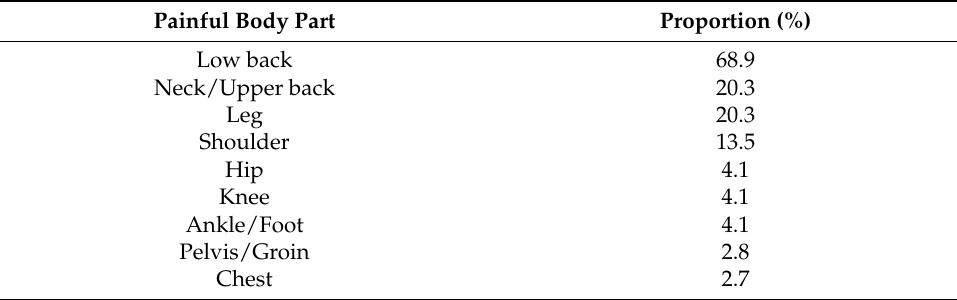
Table 2. Clinical presentation of HWDS intervention cohort.